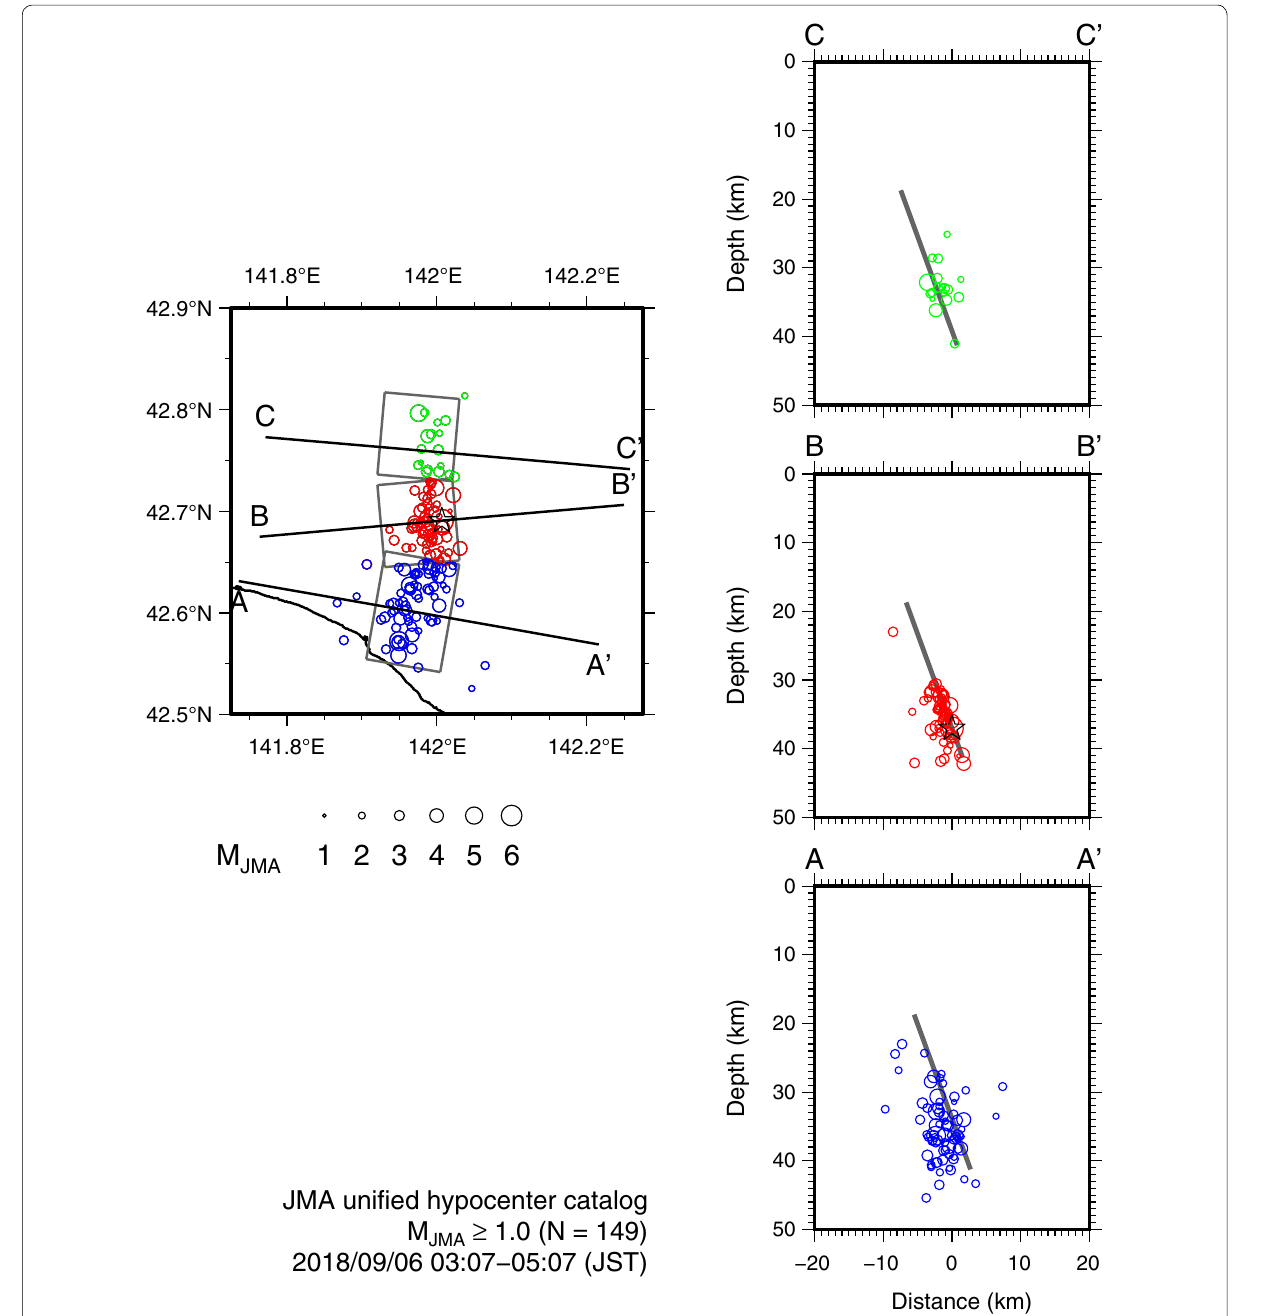
Fig. 3 Early aftershocks (circles) within 2 h from the mainshock (open star) and the assumed fault plane model (gray